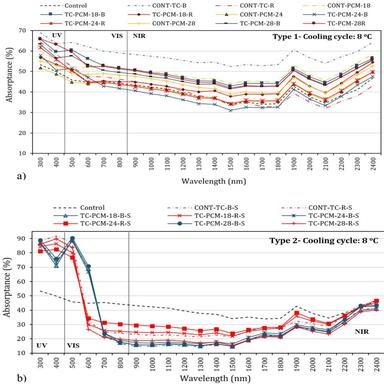
Solar absorption of the samples in the cooling cycle.